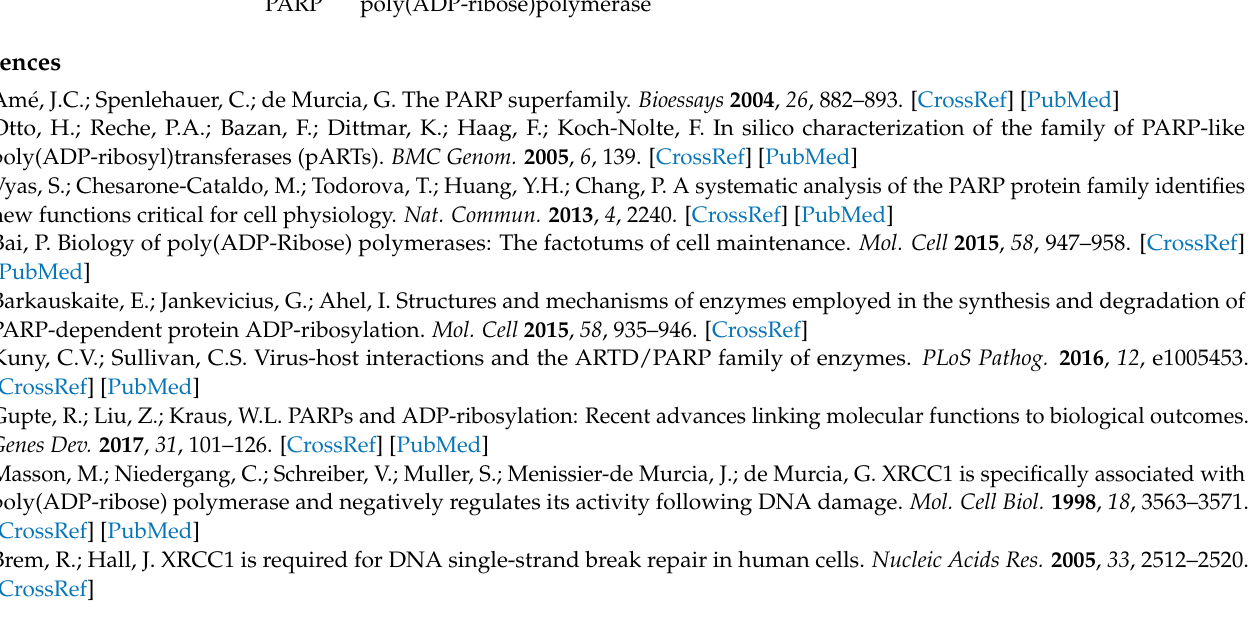
Supplementary Materials: The following are available online at https://www.mdpi.com/2072-669 4/13/6/1201/s1, Figure S1: Cluster of similar conformations of the NA binding site in PARP-1 crystal structures, Figure S2: Two possible conformations of the D-loop in crystal structures of PARP-5a, Figure S3: Interactions of 7-MG in the NA binding site of PARP-1 revealed by molecular modeling, Table S1: Crystal structures of PARPs used in the analysis of the NA binding site architecture, Table S2: Interactions between a probe inhibitor (7-MG) and NA site residues in PARPs revealed by 10-ns MD simulation, Table S3: Activity of PARP-1 and PARP-5b (tankyrase 2) at 7-MG concentration of 360 µ M determined with an immunochemical assay, Table S4: PARPs of unknown structure and their close homologues, Table S5: Interactions between a probe inhibitor (7-MG) and NA site residues in PARPs revealed using homology modeling, Table S6: Missing residues in representative PARP structures, TableS7: Control data used for energy minimization and MD simulation of the PARP–7-MG